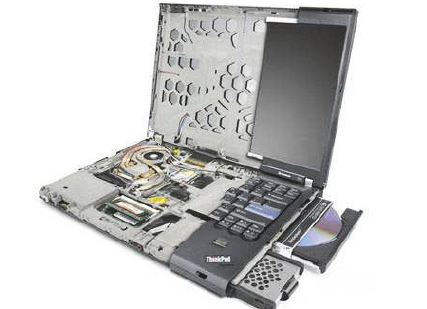
Figure 6: ThinkPad laptop shell of the carbon fiber with integrated